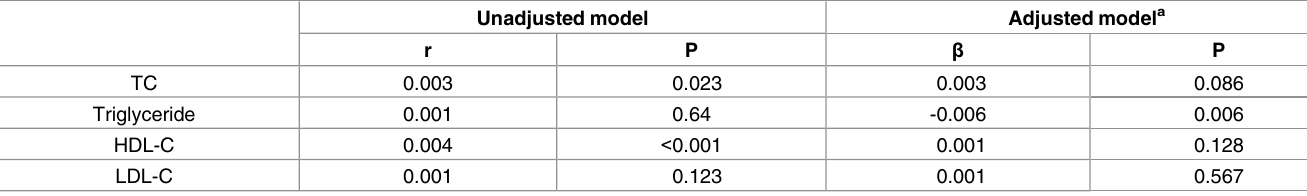
Table 3. Linear regression analyses of the association between mGFR and serum lipid components levels. mGFR indicatesmeasured glomerular filtration rate; TC total cholesterol; HDL—C high-densitylipoproteincholesterol; LDL-C low-density lipoproteincholesterol.